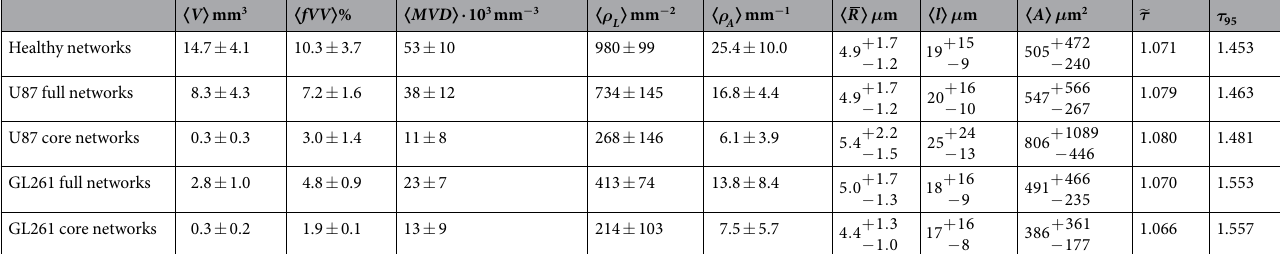
Table 1. Global tissue properties from n = 6 healthy brain hemispheres (healthy networks) and tumor specimens (full networks and exclusively tumor cores). Means with standard deviation (SD) are given for the tissue volume of each specimen V (after shrinkage from clearing), fractional vessel volume fVV , microvascular density MVD , total vessel length density ρ (in mm/mm 3 ), and vascular surface density ρ (in mm 2 /mm 3 ). L A Arithmetic means and average directed deviations of geometric vessel properties with log-normal distributions, namely mean radius r , segment length l and surface area A . The exponentially distributed segment tortuosity τ is characterized by the median τ  and 95%-quantile τ . 95